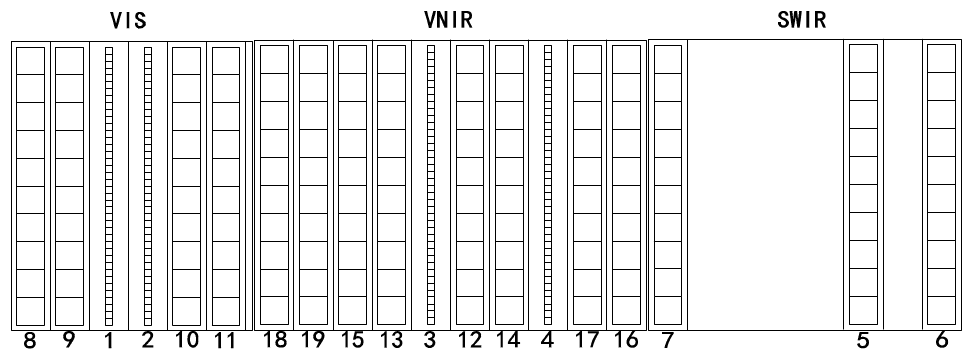
Figure 4. MERSI focal plane assemblies (FPAs). The visible (VIS) FPA comprises bands 8, 9, 1, 2, 10, and 11; the visible and near-infrared (VNIR) FPA comprises bands 18, 19, 15, 13, 3, 12, 14, 4, 17, and 16; and the short-wave infrared (SWIR) FPA comprises bands 7, 5, and 6.